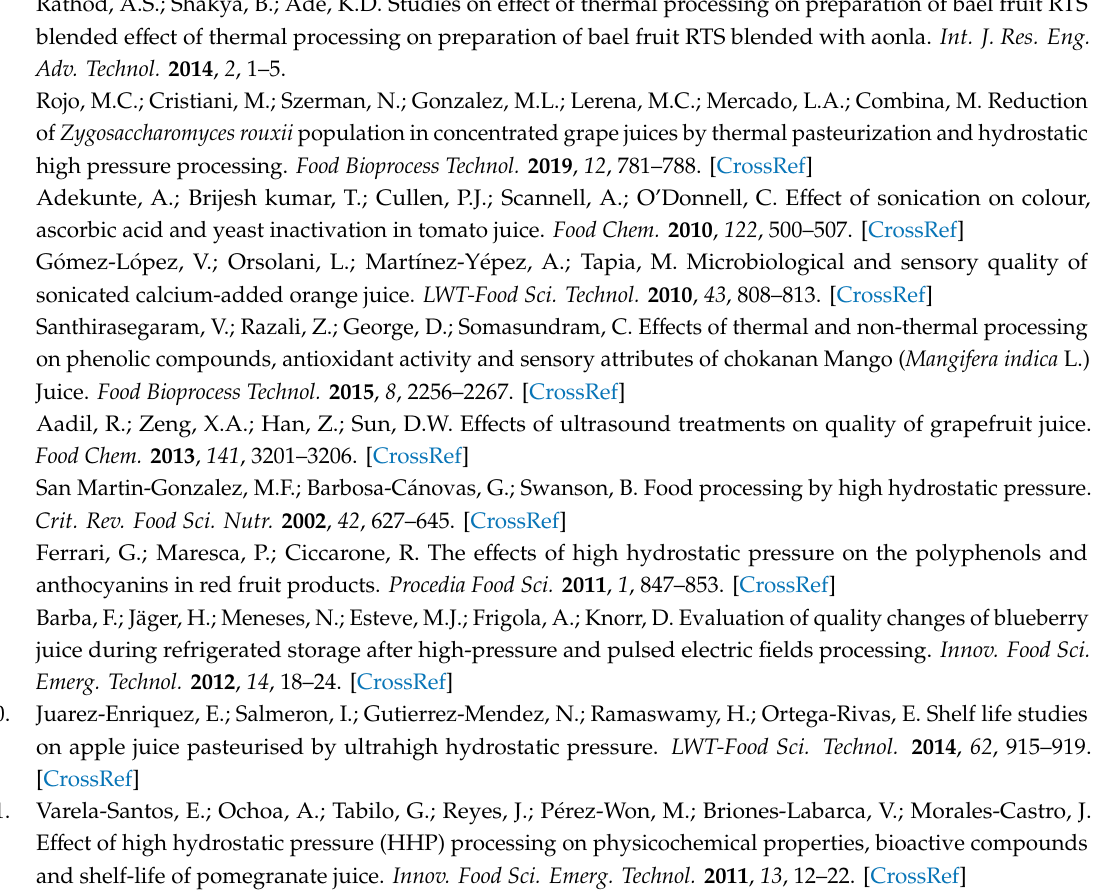
Table S1: Sensory attributes and reference scores used for sensory evaluation of juice